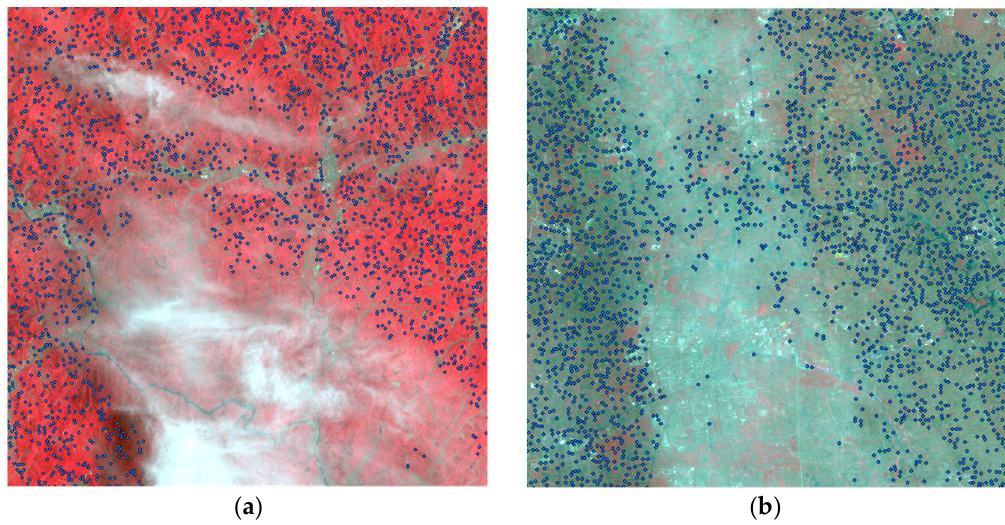
Figure 2. Dark pixel extraction results for diverse land cover types (w = 7, P = 30%); the blue points represent feature points of dark pixels, where ( a ) shows the vegetation area, and ( b ) shows the urban region.